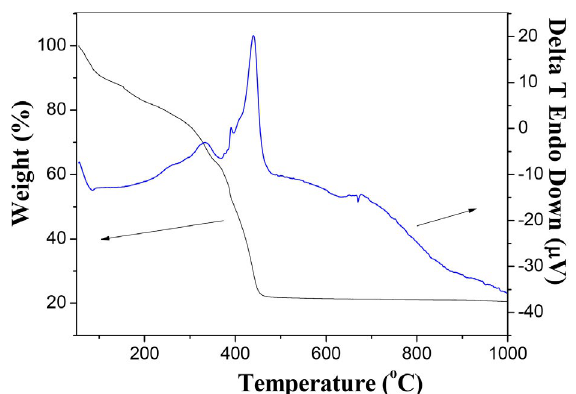
Figure 5. DT-TGA curves of 1.